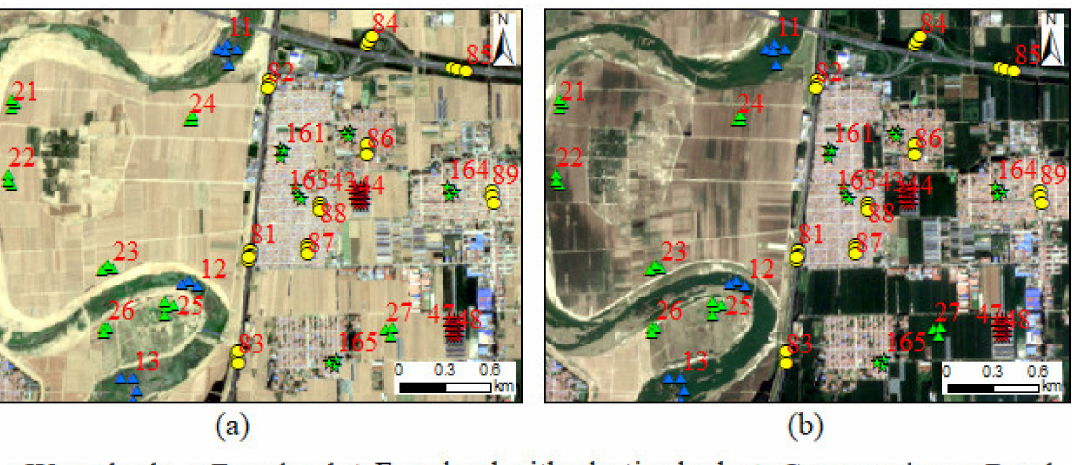
Figure 5. Sample points in rainless scenarios: ( a ) the base map was a Planet RGB composite image on 26 June 2019; ( b ) the base map was a Planet RGB composite image on 26 June